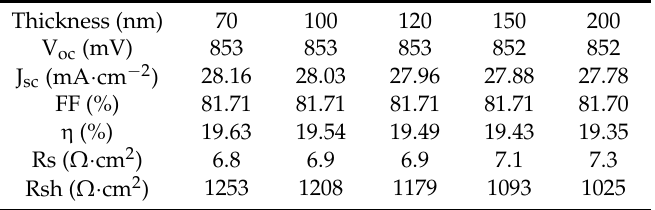
Table 4. Dependence of CdTe solar cell performance parameters on thickness of ZMO:In (x =